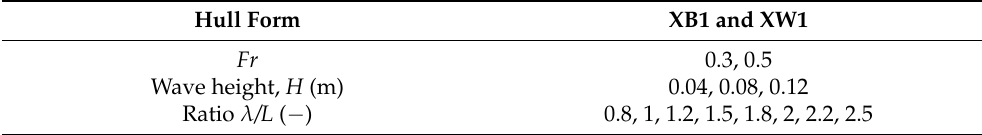
Table 5. Summary of test conditions.